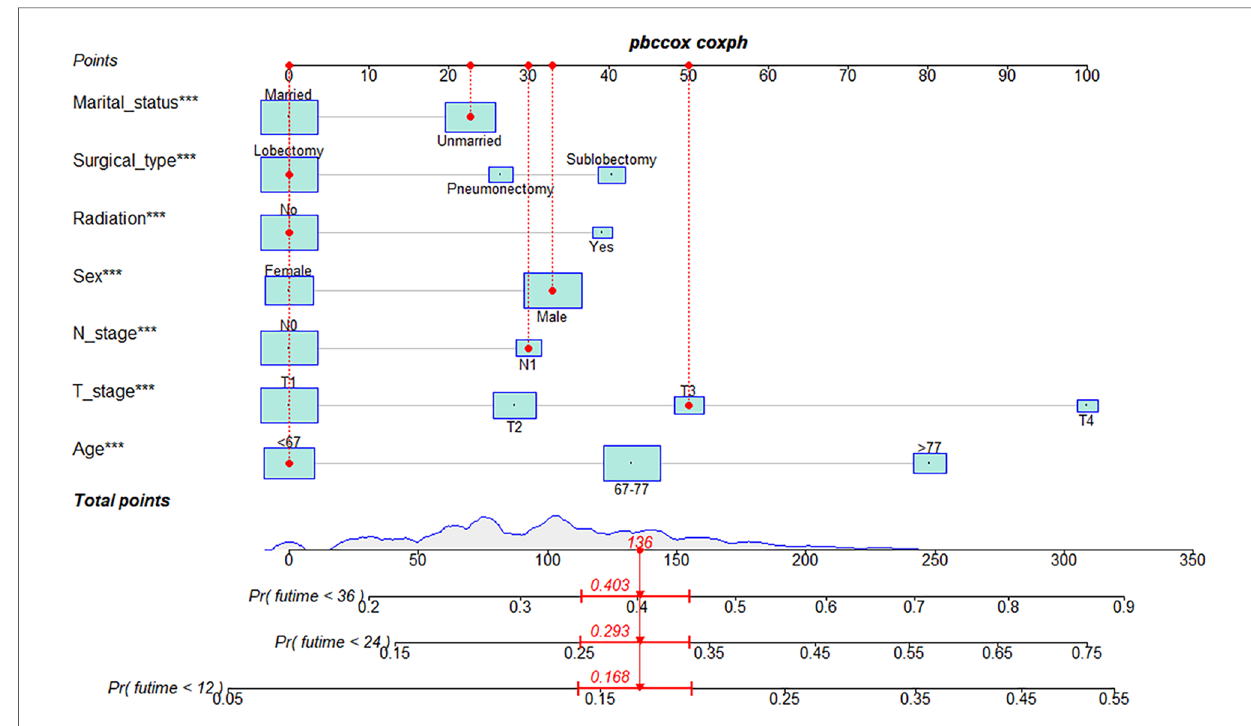
FIGURE 1 Nomograms to predict 1-, 2- and 3-year OS for postoperative LSCC patients. OS, overall survival; LSCC, lung squamous cell carcinoma.